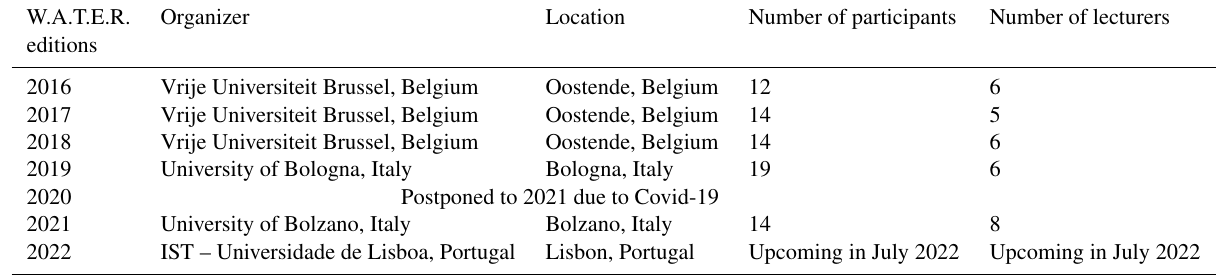
Table 1. W.A.T.E.R. editions and the locations, number of participants, and lecturers. W.A.T.E.R.